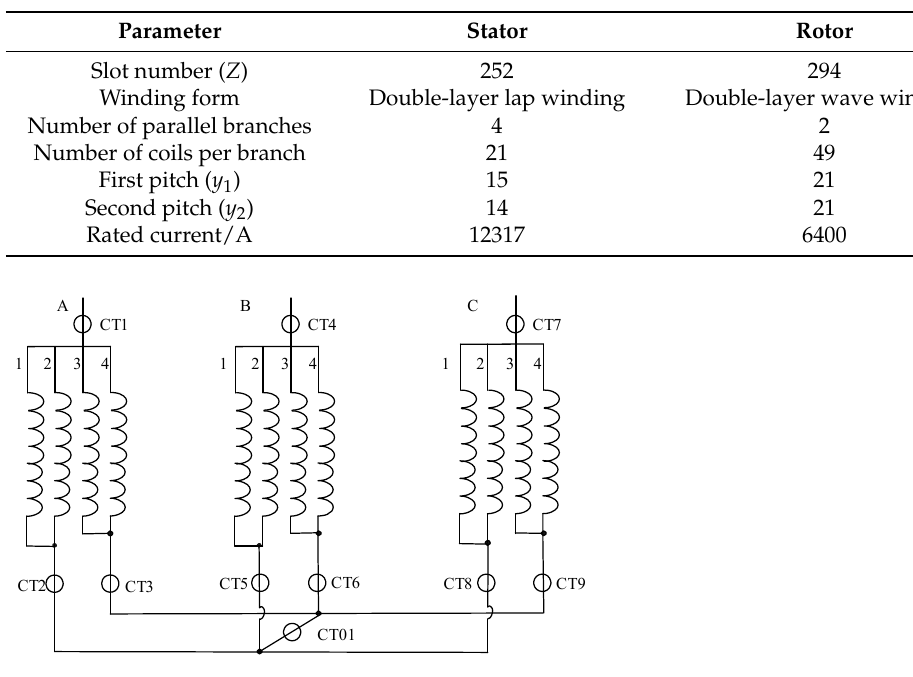
Figure 2. Stator winding branch wiring diagram.